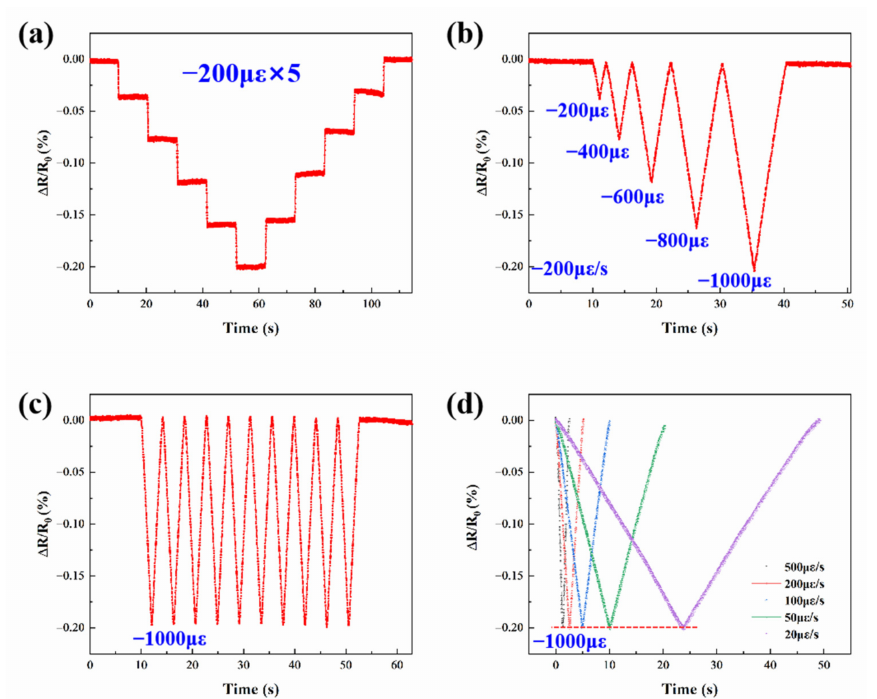
Figure 4. ( a – d ) are tensile strain response of Pt TFSGs. Figure 4. (a), (b), (c), and (d) are tensile strain response of Pt TFSGs.